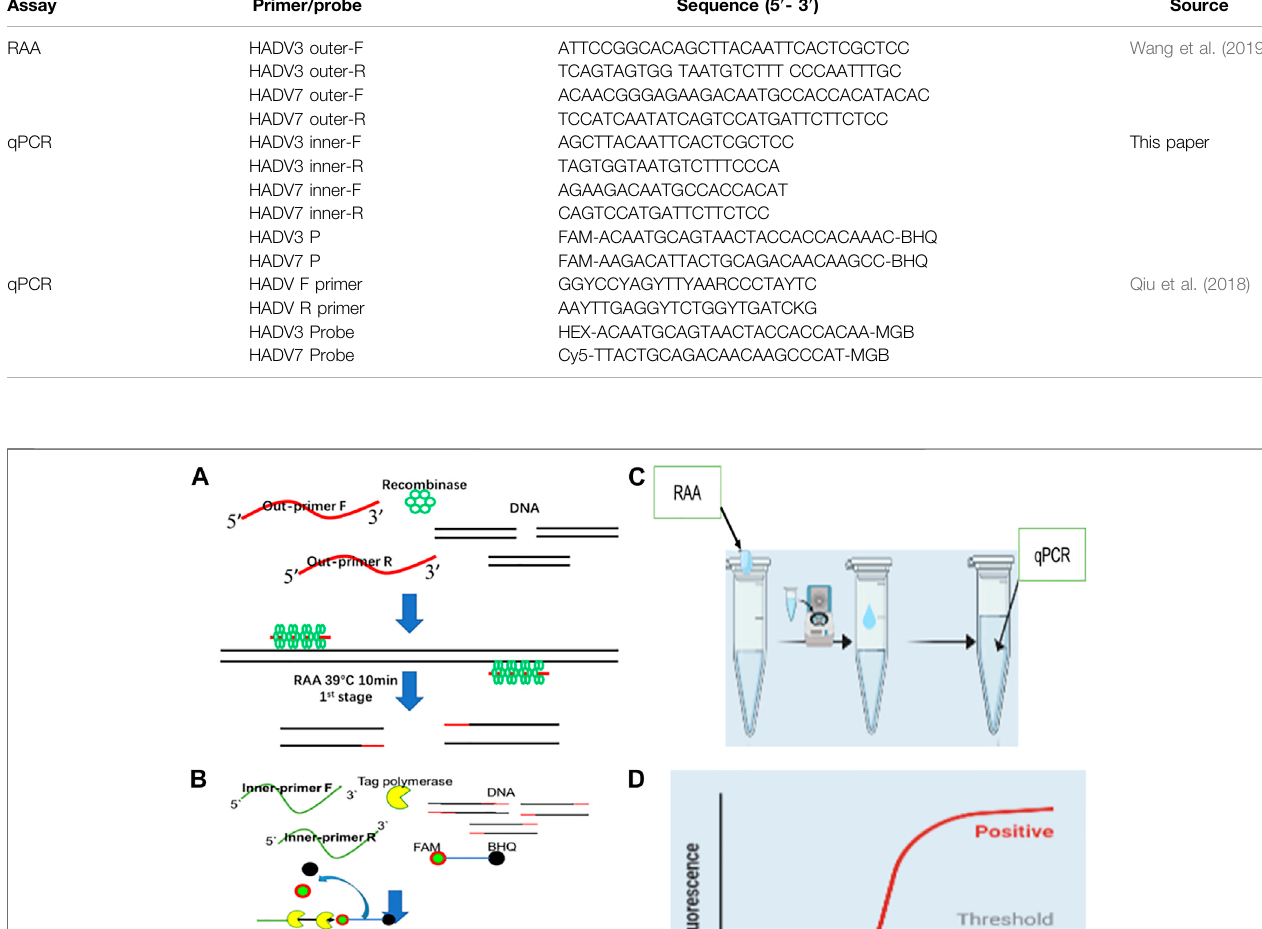
TABLE 1 | Primers and probes sequences used in this study. Assay